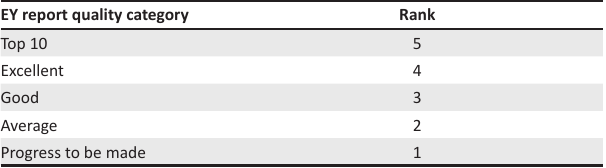
TABLE 3: Integrated report quality ranking per Ernst and Young report quality